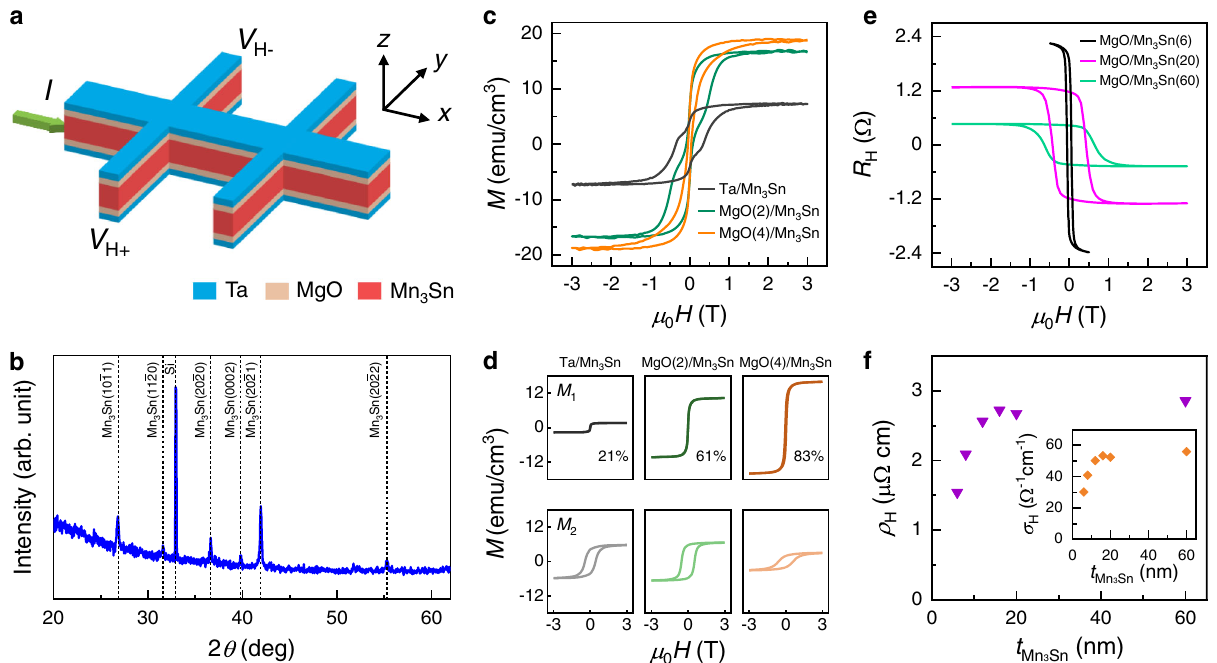
d Decomposed sub-loops of the M-H loops in c . e Field dependence of Hall resis- )with t Mn =6,20,60nm at 300K. f Extracted tance R H forTa/MgO/Mn 3 Sn( t Mn 3 Sn 3 Sn anomalous Hall resistivity ρ H as a function of t Mn . Inset: anomalous Hall con- 3 Sn ductivity σ H as a function of t Mn 3 Sn